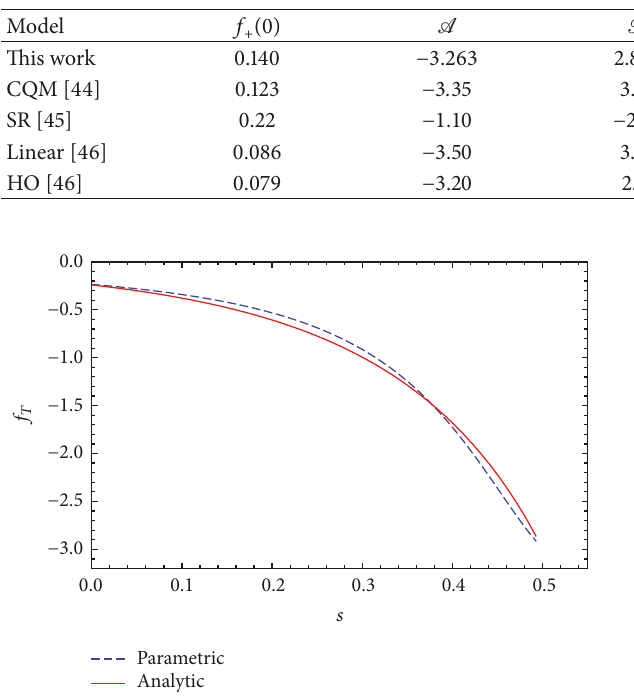
Figure3:Analyticsolutionsof 𝑓 푇 (thicksolidcurve)comparedwith the parametric results (dashed curve), with definition 𝑠 = 𝑞 2 /𝑀 2 퐵 +